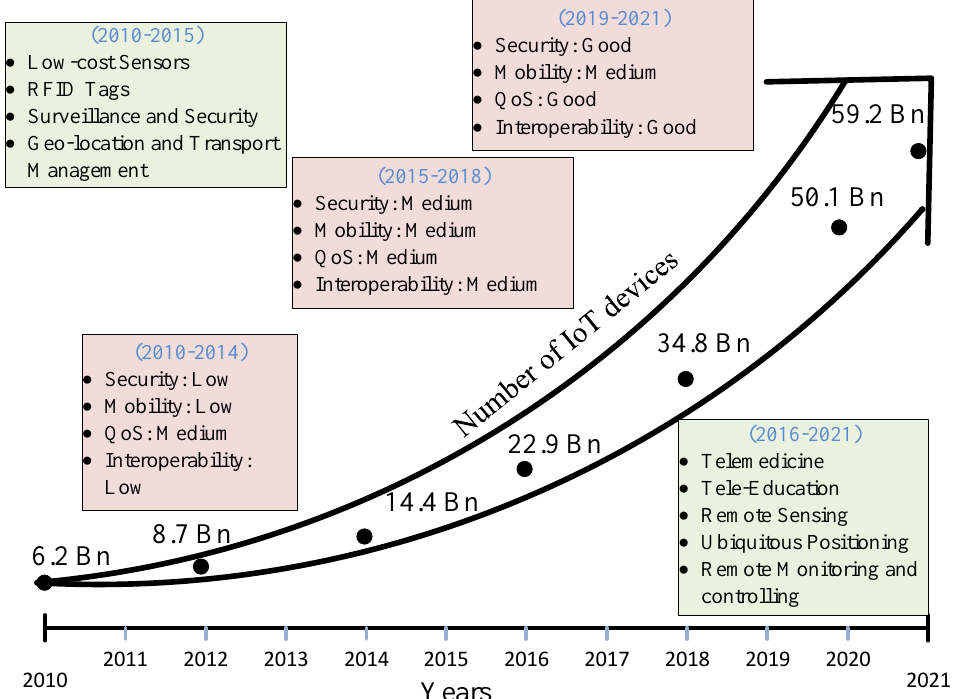
Figure 4. IoT Evolution with